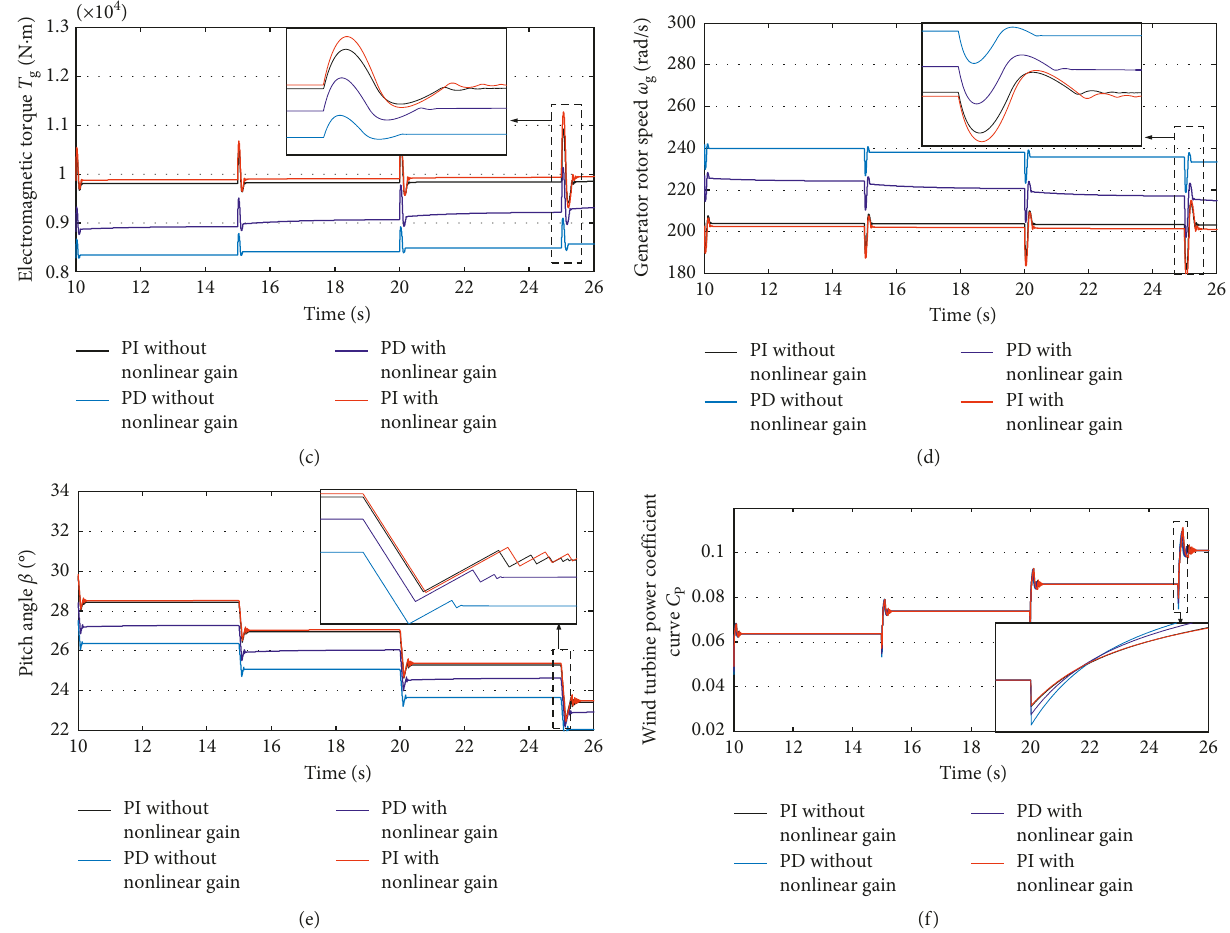
Figure 19: Responses under step-change wind speed. (a) Wind speed curve. (b) Electromagnetic power curve. (c) Electromagnetic torque curve. (d) Generator rotor speed curve. (e) Pitch angle curve. (f) Wind turbine power coefficient curve.